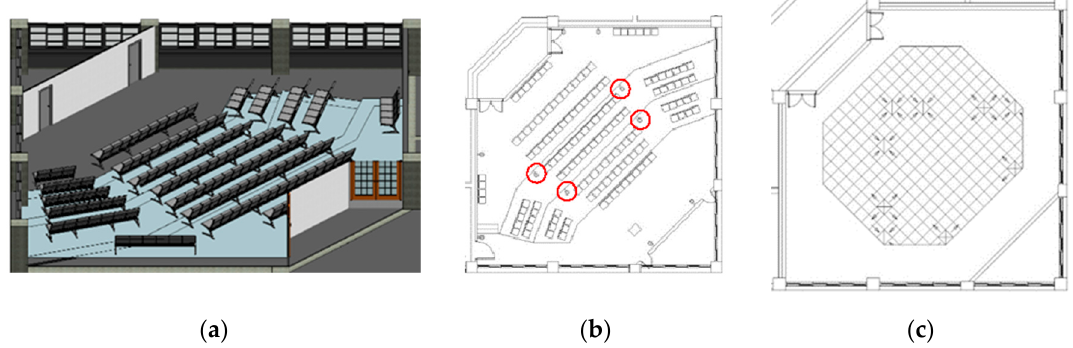
Figure 5. The BIM model and space configuration. ( a ) BIM Model; ( b ) Sensor Setup Location; ( c ) Air Conditioning Outlet.